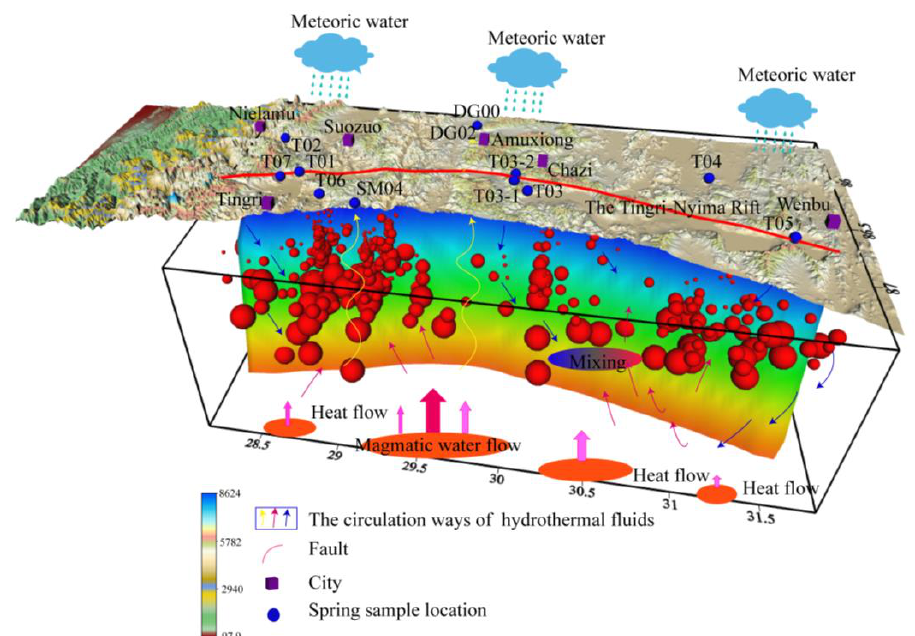
Figure 9. The fluid circulation model in the TNR.